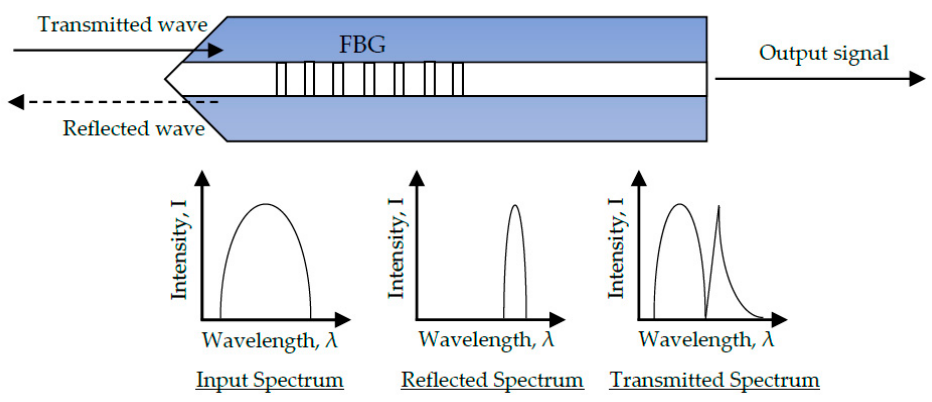
Figure 8. Typical transmission and reflection spectra from a fibre Bragg grating sensor (after [154]).